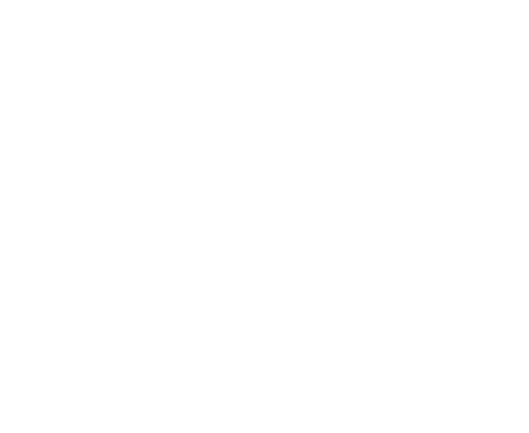
Figure 19. Metrics analysis of the data format configurations; a good value of resource utilization, latency, noise, and MSE should be close to 0; by contrast, a good value of low contrast and uniformity should be close to